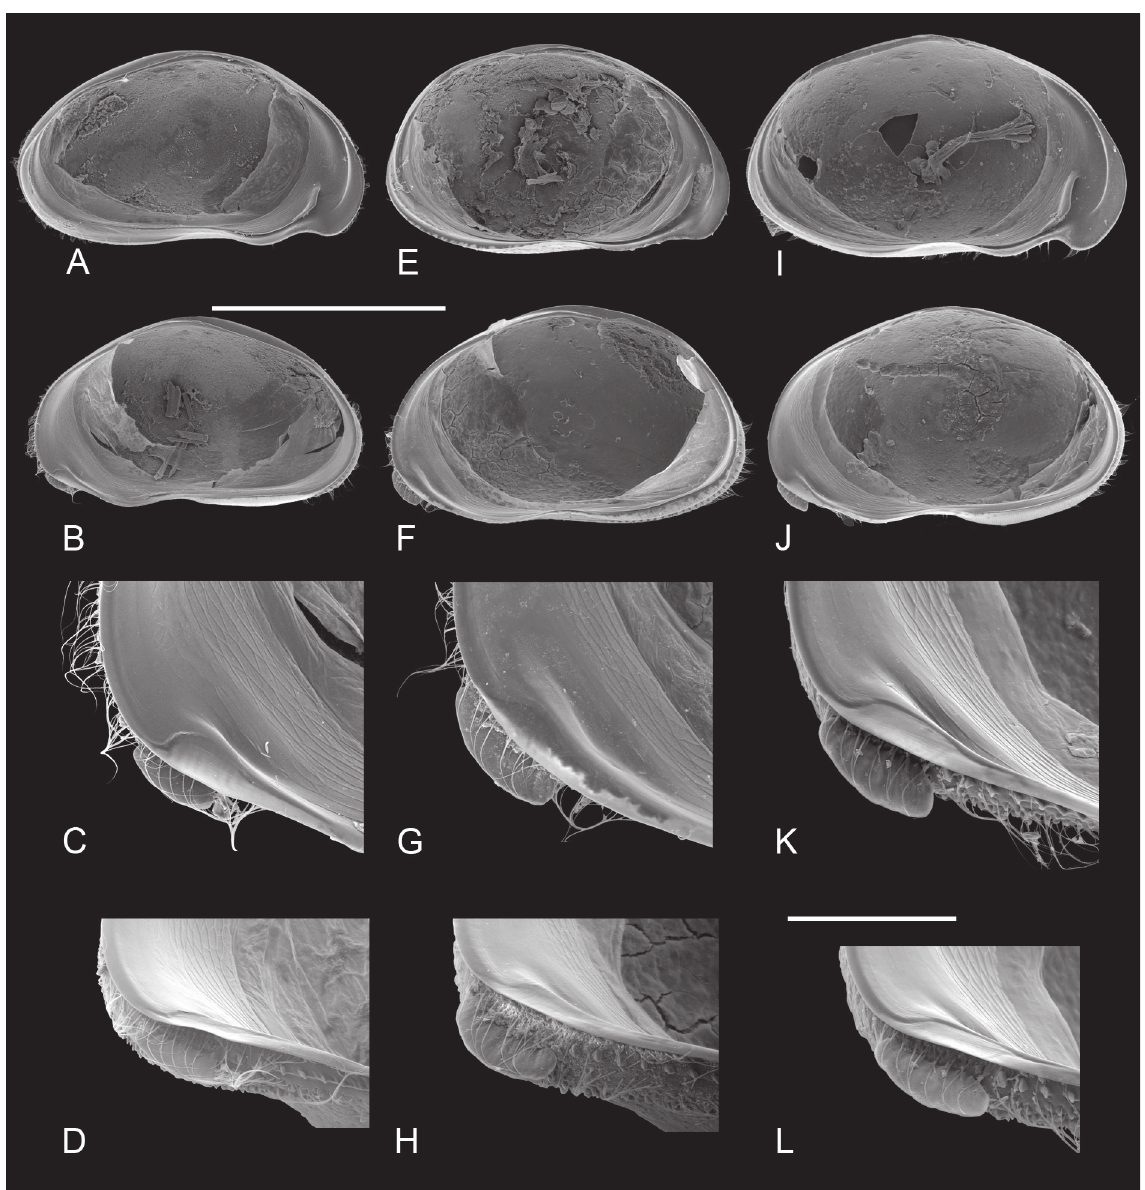
Fig. 25. Bennelongia spp. (no museum nrs). — A-D . Bennelongia sp. X2, three springs tumulus Stream (♀, KMWA.917). A . lVi. B . rVi. C . rVi, detail anterior. D . rVi, detail anterior, tilted. — E-H . Bennelongia sp. nov. E2, BYK (♀, KMWA.806) = Species E2 in Figs 2-3. E . lVi. F . rVi. G . rVi, detail anterior. H . rVi, detail anterior, tilted. — I-L . ? Bennelongia scanloni sp. nov., pool near Esperance (♀, Os.004). I . lVi. J . rVi. K . rVi, detail anterior. L . rVi, detail anterior, tilted. scales: a-B, e-F, I-J = 1 mm; c-D, G-H, K-l = 200